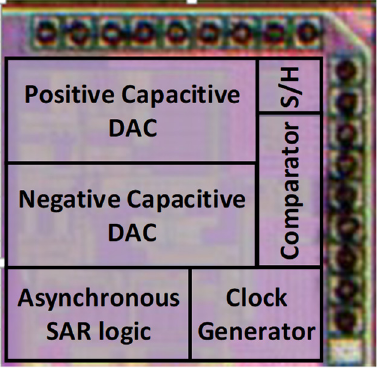
Figure 12. Die photograph of the implemented ADC.